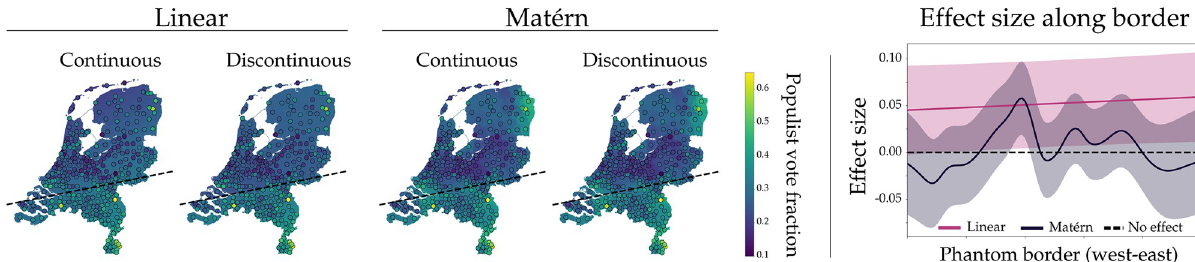
Fig 5. Phantom-border effects on populist voting. Discontinuity analysis along a two-dimensional boundary (indicated by the dashed line). A . Circles indicate the observed fraction of populist votes; municipalities are shaded according to the Gaussian process predictions. B . The distribution of effect size conditioned on M , p ð d j D ; M Þ , along the phantom border. The shaded interval indicates one standard deviation around the mean. The country 1 1 and municipality border data are available at the website of the Dutch national georegister [50], and the superimposed populist voting fractions were derived from the 2017 election results at https://data.overheid.nl